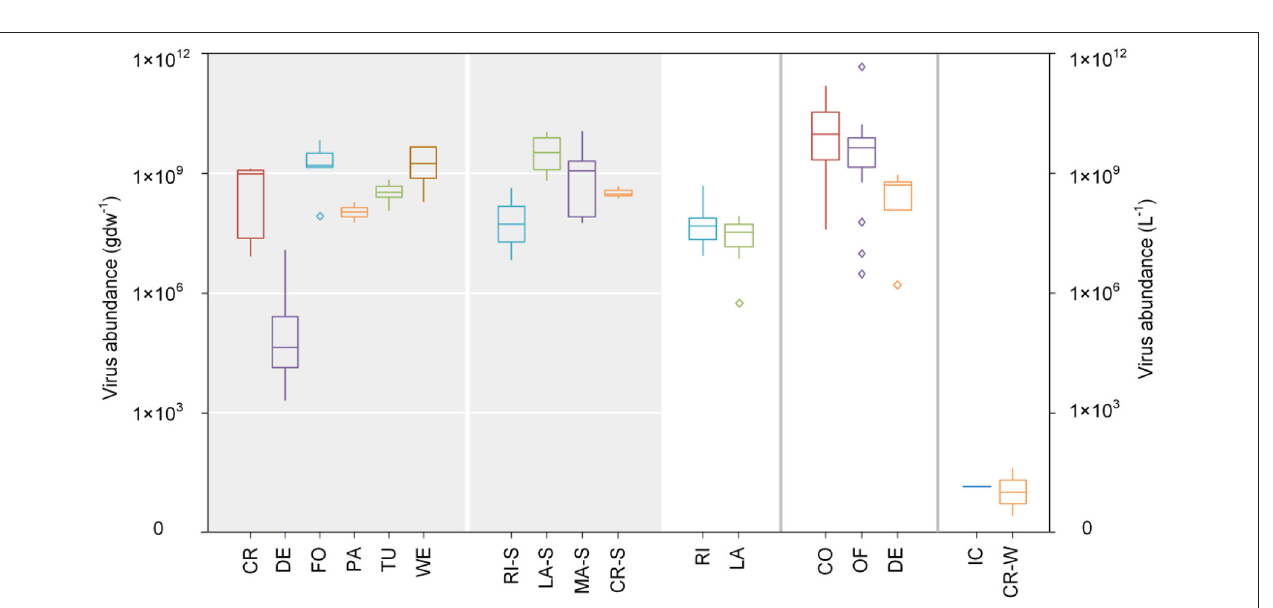
The abundance of phytoplankton hosts of viruses in rivers and lakes is ∼ 4.8 × 10 7 L − 1 and 3.5 × 10 7 L − 1 ( Figure 3 ), respectively, which is frequently many times the magnitude of resident bacterial abundance (42). Virus abundance in river sediments is approximately 2.1 × 10 8 gdw − 1 , which is less